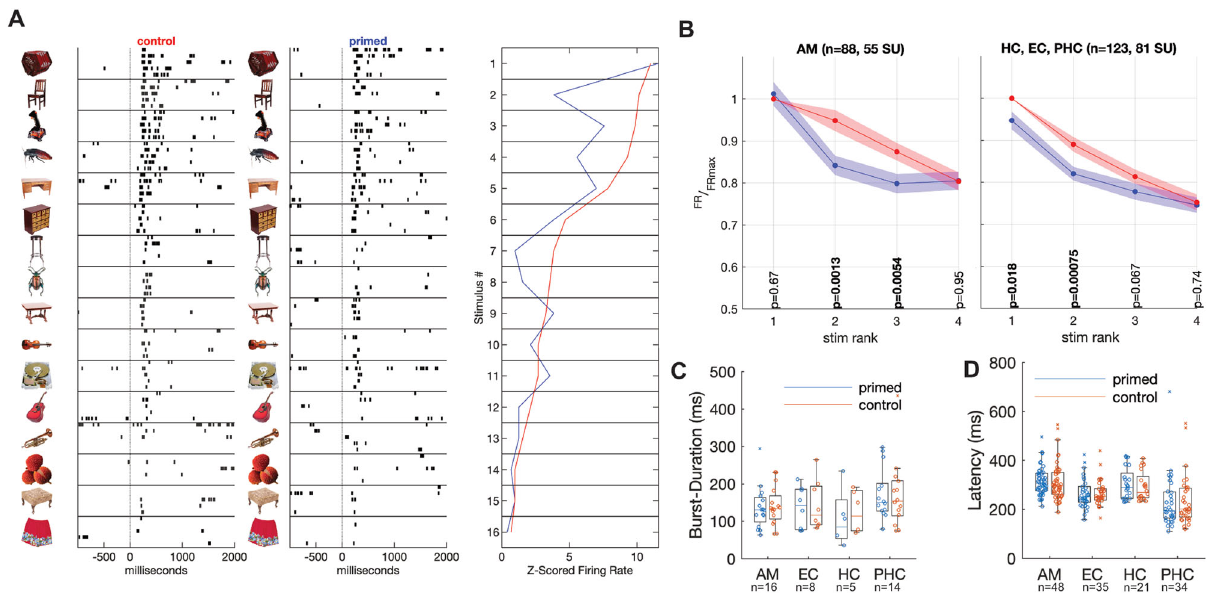
Fig. 2 | Sharpening in single-unit responses to multiple stimuli. A The panel depicts data from one unit. The left two columns depict raster-plots to the 16 sti- muli eliciting the strongest responses, separately for the primed and control con- dition, sorted from top to bottom according to response strength in the control condition. The column on the right depicts the average fi ring rate during the response-period [0 – 1s], normalized to the baseline [ − 0.5 – 0s] as a Z -score. Source dataareprovidedasSourceData fi le(SourceData.xlsx). B AveragesofallcurvesinA fromthe211unitsrespondingto4ormoreresponse-elicitingstimuli.Apaired t -test of primed vs.controltuningcurveswasperformed foreachrankon the x -axis,and theresulting p -valuesprintedinboldifsigni fi cantat α <0.05.Moreinformationon the results of t -tests is given in the following. Sample size n =88 units in the amygdala (AM). Rank 1 primed vs. control: t (87)=0.43, CI=[ − 0.044 0.069], p =0.67;rank2primedvs.control: t (87)= − 3.3,CI=[ − 0.17 − 0.043], p =0.0013;rank 3primed vs. control: t (87)= − 2.9,CI=[ − 0.13 − 0.023], p =0.0054;rank4 primed vs. control: t (87)=0.057, CI=[ − 0.048 0.051], p =0.95. Sample size n =123 units in the hippocampus, entorhinal and parahippocampal cortex (HC, EC, PHC). Rank 1 primedvs.control: t (122)= − 2.4,CI=[ − 0.097 − 0.0093], p